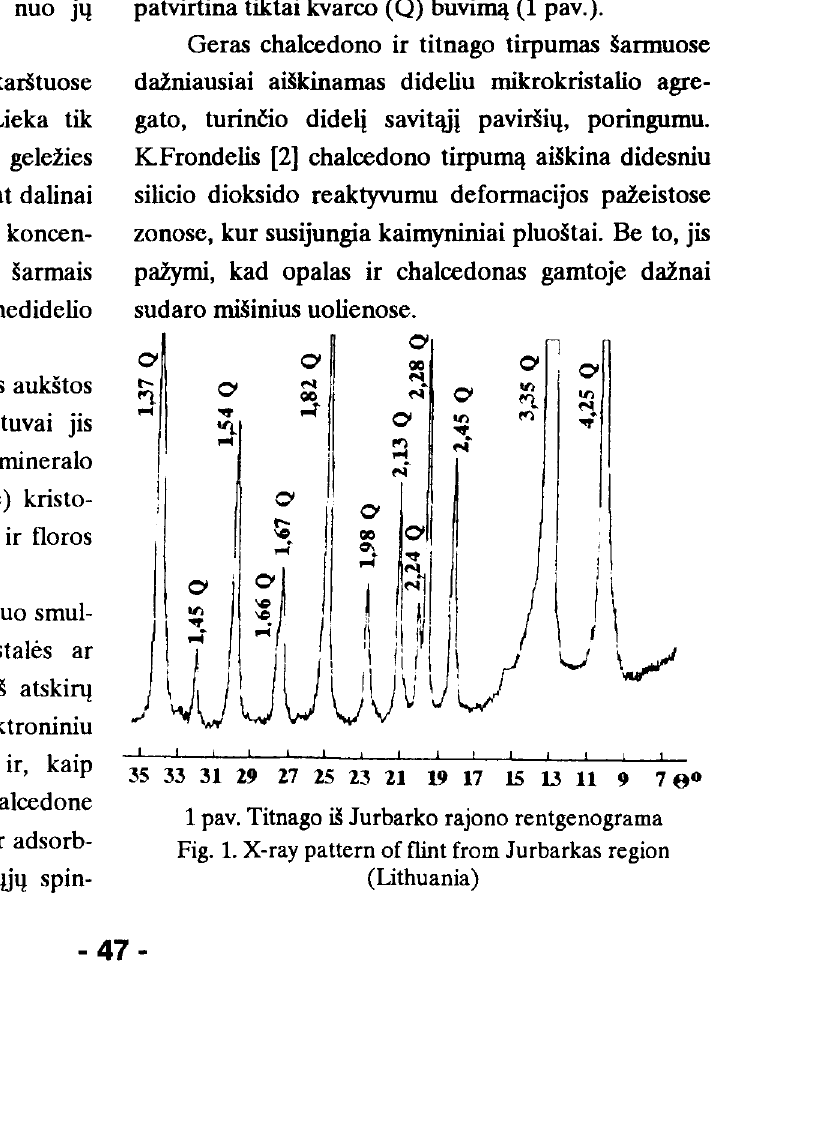
Fig. 1. X-ray pattern of flint from Jurbarkas